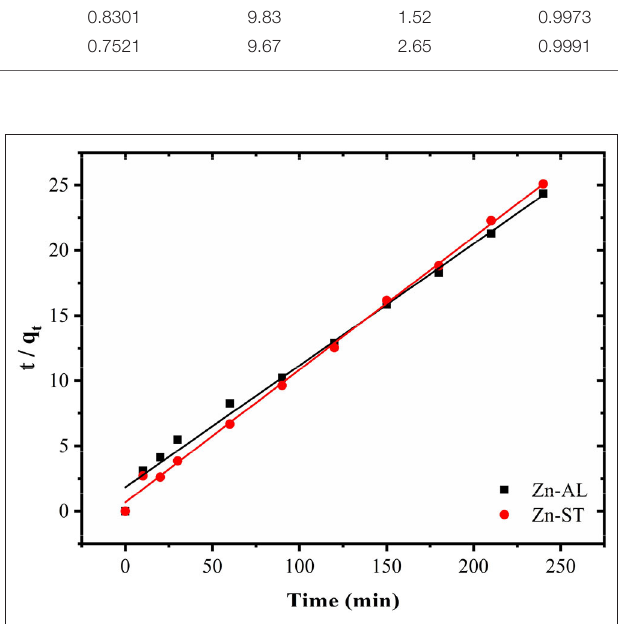
FIGURE 10 | Kinetic parameters for Cu (II) removal using Zn-AL and Zn-ST as adsorbent.